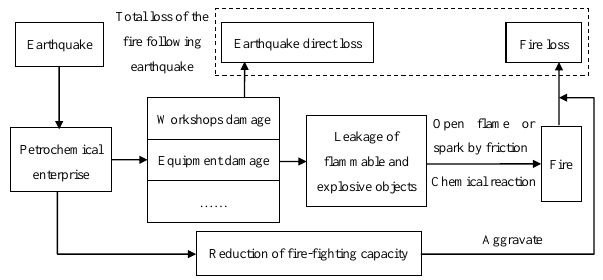
Figure 1. Post-earthquake fire causing mechanism of the petrochemical enterprises.